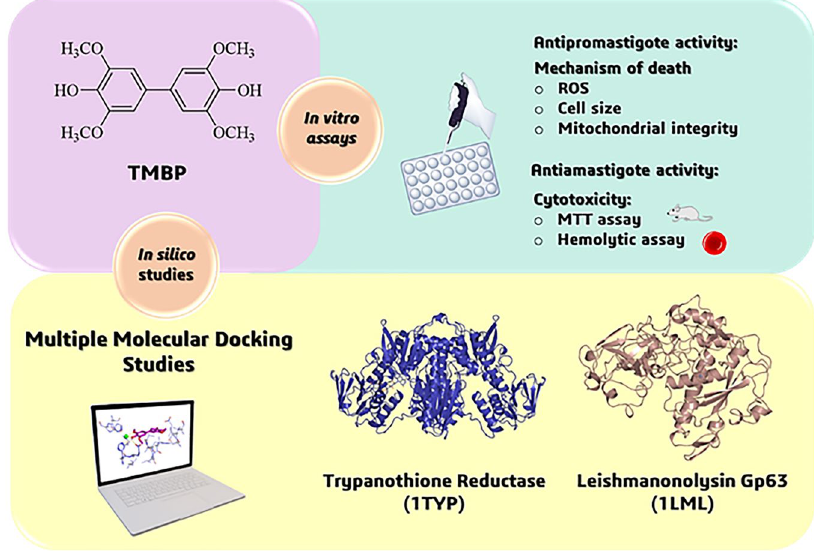
Figure 1. The experimental approach to leishmanicidal evaluation and molecular docking of TMBP.